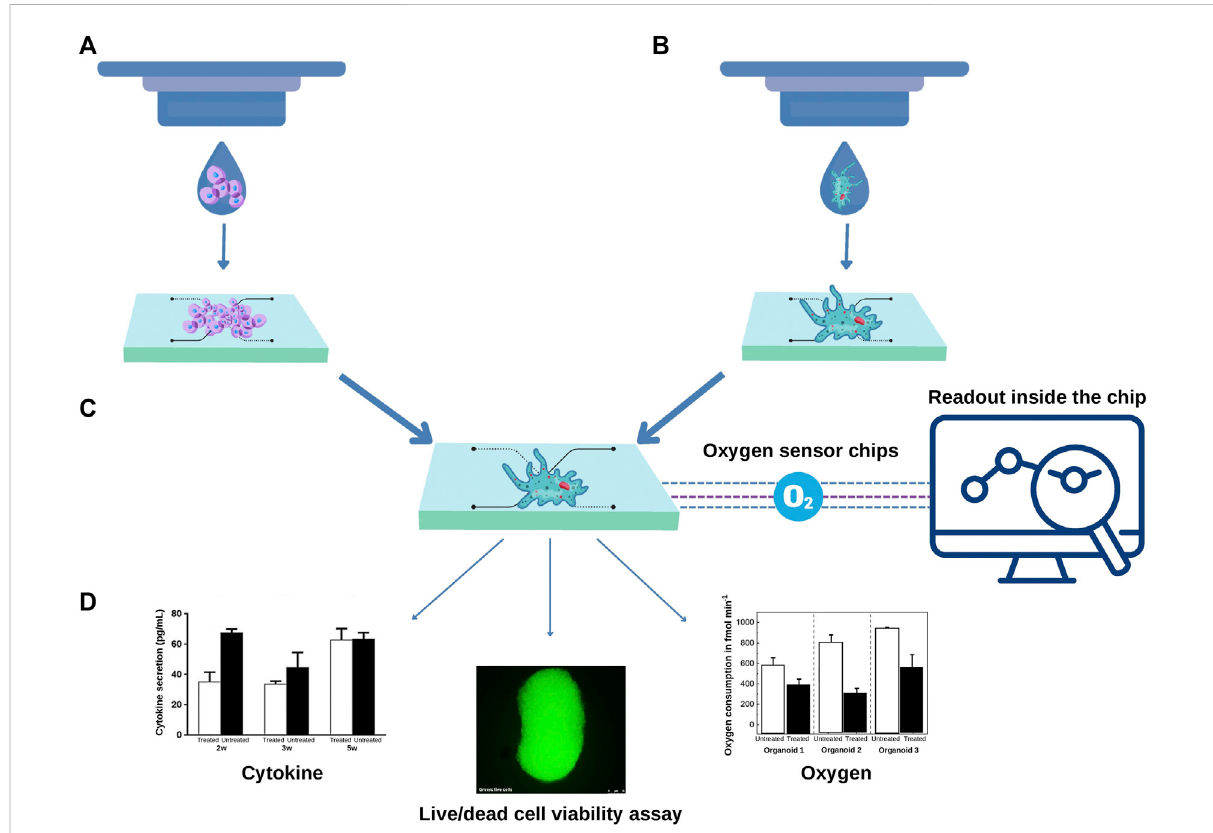
FIGURE 2 3D Bioprinting approaches can contribute to scalability of organoids-on-a-chip. (A) A cell suspension can be bioprinted inside a predesigned chip toform organoids or (B) organoidscanbedirectly bioprinted inside aregular chip.Inboth scenarios thedevelopment ofaspeci fi ccomposition ofbioinkaccordingtothetypeoforganoidisrequired. (C) Themicro fl uidicschipscancontainsensors,forexample,tomeasurethereal-timeoxygen consumptionfromeachorganoid.Additionalassayscanbecarriedout insidethechip.Theorganoidculturesupernatantcanbeharvested,and the levels of cytokines measured using multiplex assays. Optical transparent chips also allow fl uorescent-based assays such as live and dead viability assay (D)